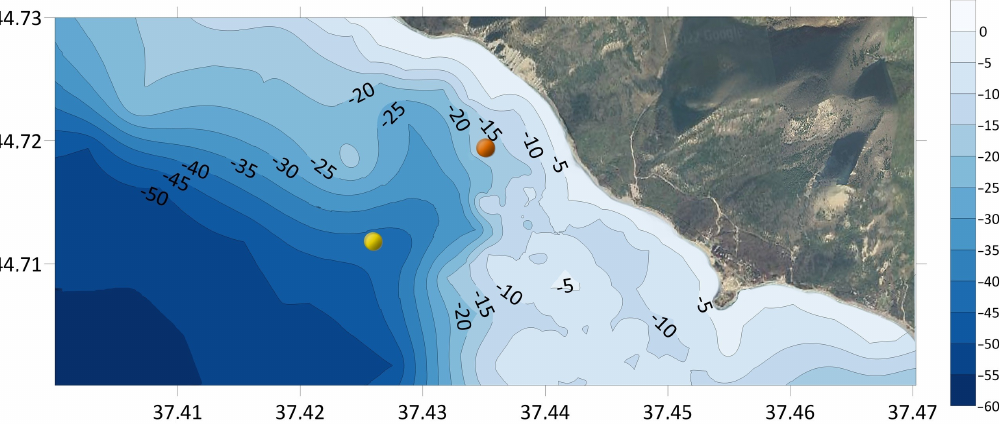
Figure 2. Thermistor chain location and bathymetry (m). The red circle indicates the first and second measurement period, and the yellow one indicates the third measurement period after 15 March 2020.